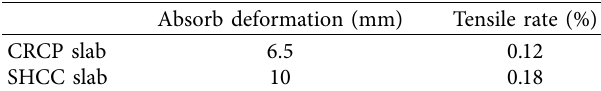
Figure 9: Stress diagram of SHCC when temperature decreases. Table 6: Comparison of absorption deformation capacity between CRCP slab [18] and SHCC